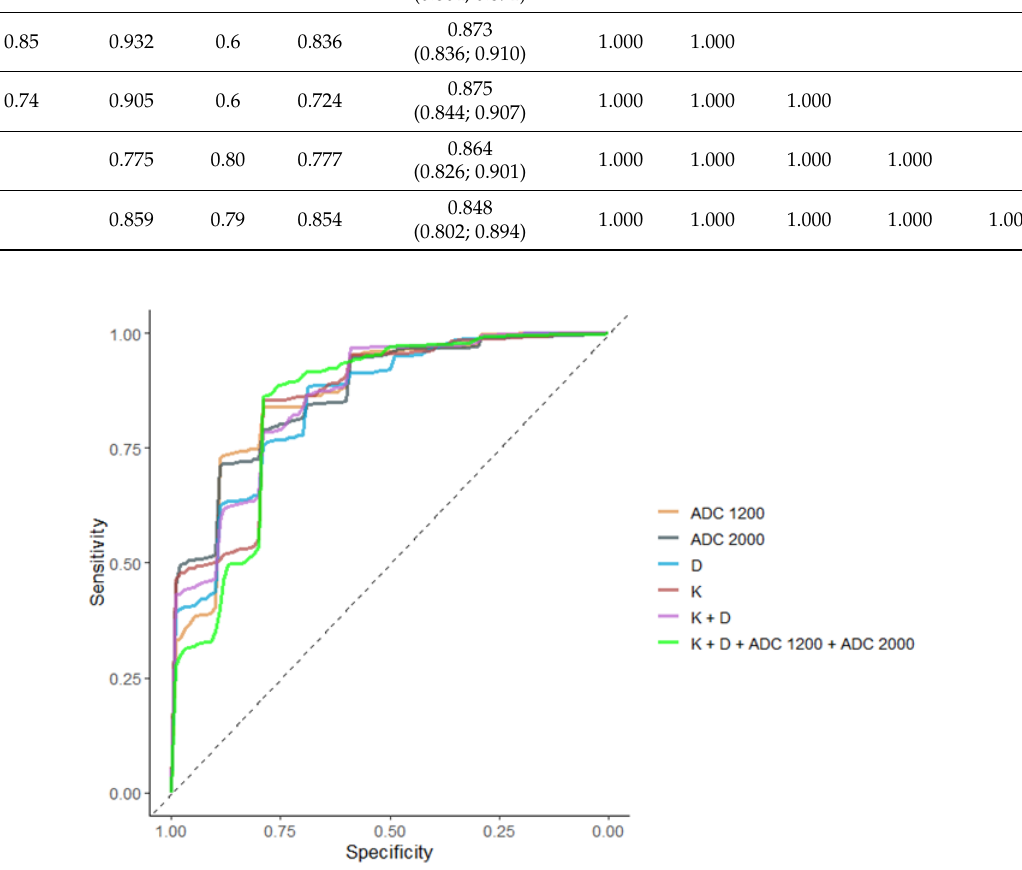
Figure 6. ROC curves of the performance of D app , K, ADC 1200 and ADC 2000 , K + D, and K + D + ADC 1200 + ADC 2000 for differentiating GS ≤ 3 + 3 and GS ≥ 3 + 4 tumors in the peripheral zone. The models do not differ significantly.